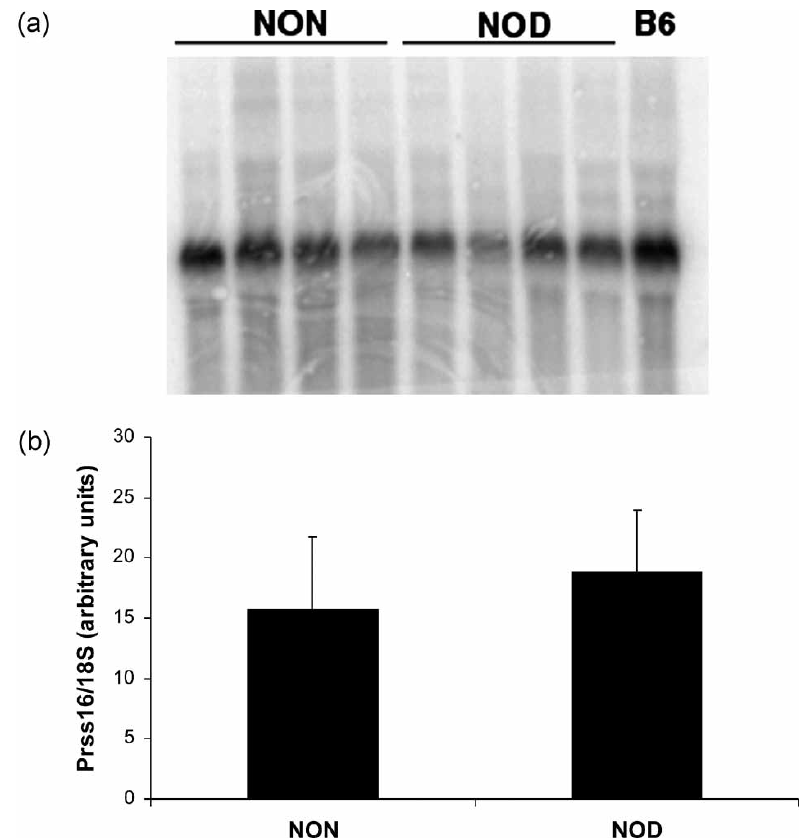
FIGURE 1 (a) Northern hybridization of Prss16 probe to total thymus RNA from C57BL/6, NOD ð n ¼ 4 Þ and NON ð n ¼ 4 Þ mice. (b) Prss16 mRNA relative to 18S ribosomal RNA in thymic stromal cells from the thymi of three weeks old male NOD ð n ¼ 4 Þ and NON ð n ¼ 4 Þ mice. Shown is the average and SEM for Prss16 mRNA relative to 18S rRNA.